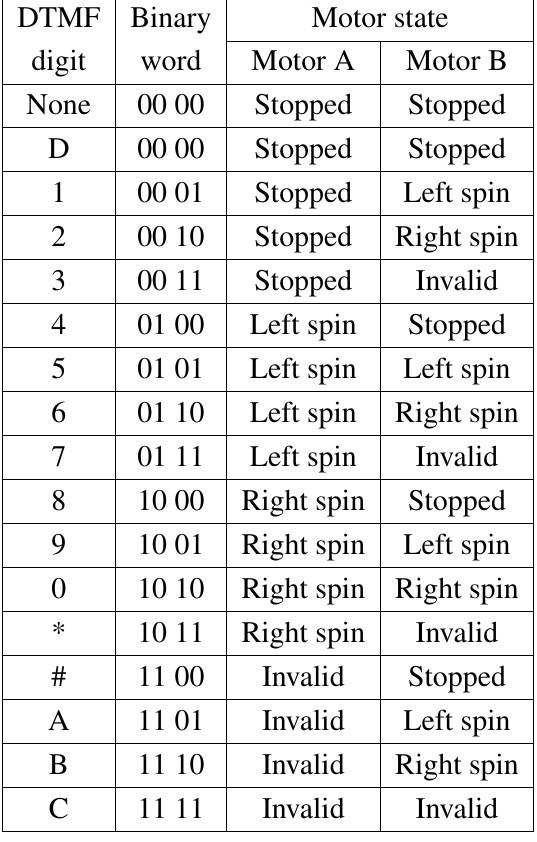
Table 2. DTMF digits and corresponding motors